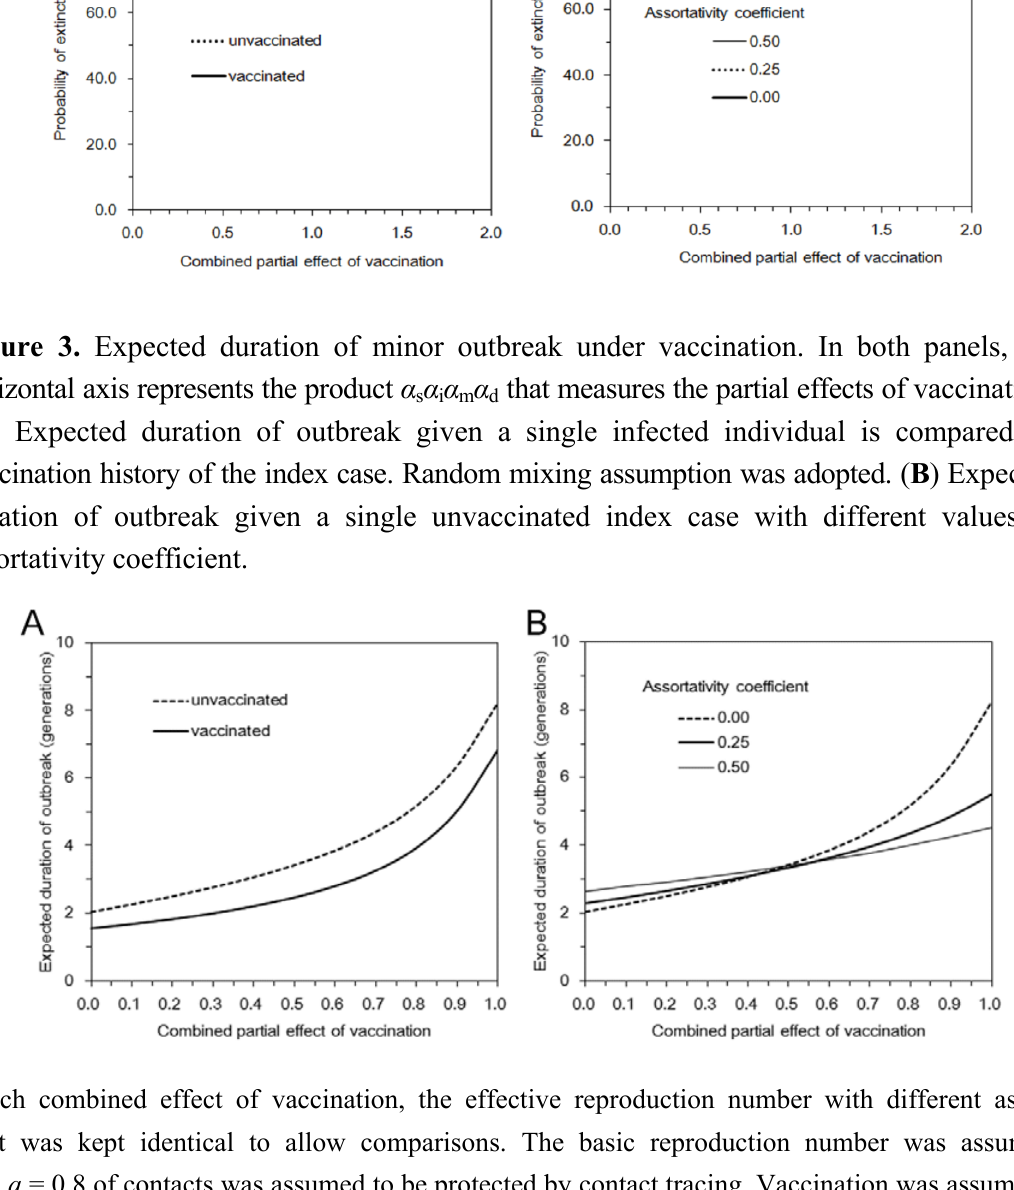
Figure 2. Probability of extinction and combined effect of vaccination. In both panels, the horizontal axis represents the product α vaccination. ( A ) Probability of extinction given a single infected individual is compared by vaccination history of the index case. Random mixing assumption was adopted. ( B ) Probability of extinction given a single unvaccinated index case with different assortativity coefficient values.